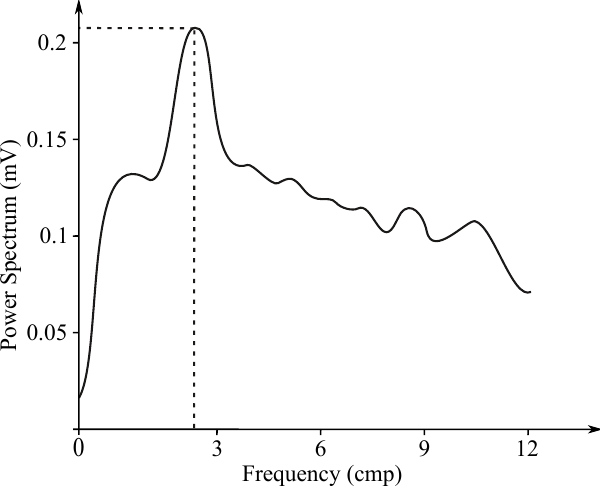
Figure 7. Sample EGG frequency